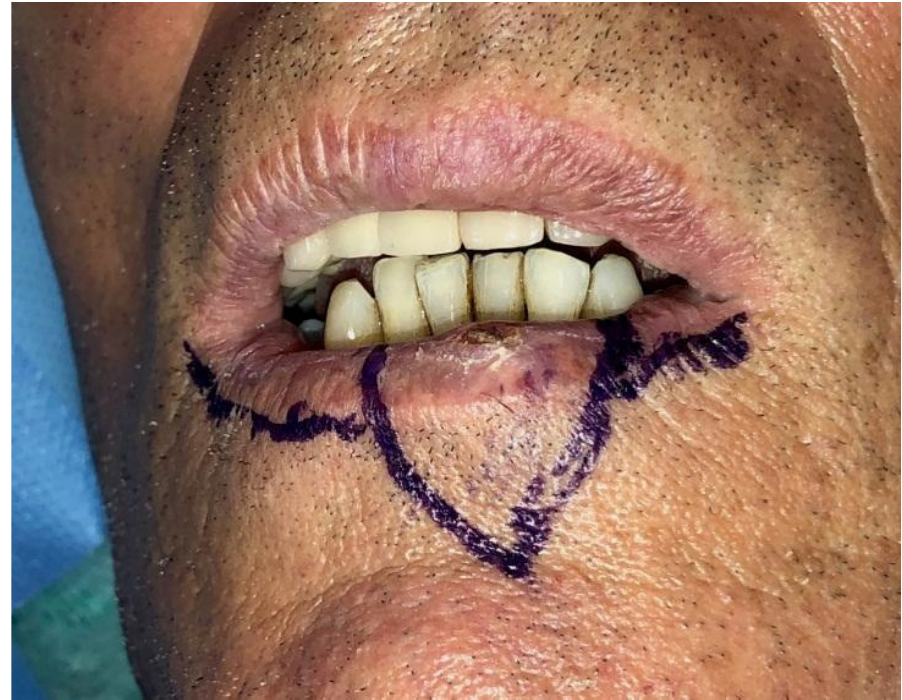
Figure 1. Case 1: Defect involving more than 1/3 of lower lip and the paramedian site.